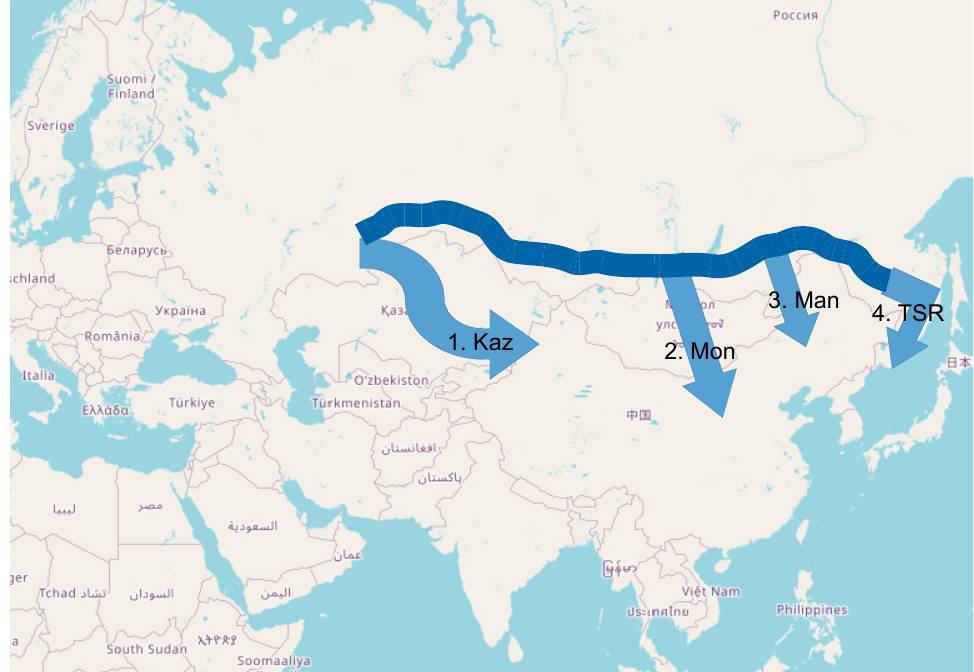
Figure 1. Four different options of Eurasian container landbridge. Denotation: “1. Kaz”, Kazakh hinterland connection; “2. Mon”, Mongolian hinterland connection; “3. Man”, Manchurian hinterland connection; “4. TSR”, Trans-Siberian connection through Russian Far Eastern sea ports. Source (background map): © OpenStreetMap contributors [17].